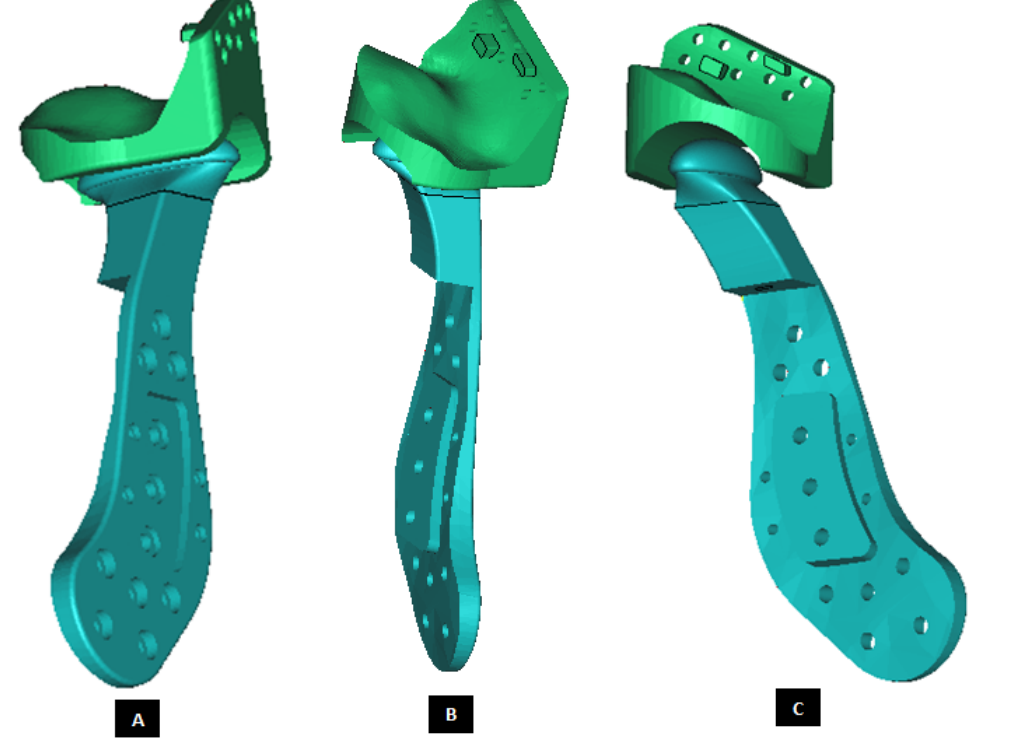
Figure 24. A patient-specific total TMJ prosthesis with medial notches in fossa and condylar compo- nents. ( A ) Shows anterior–lateral view of the ‘notched implants’ with screw holes. Fossa prosthesis has two medial notches to be fit into host bone ( B , C ). The articular surface of fossa implant has medio–lateral openings, and is designed to allow optimal anterior and medial translation along with rotation of the prosthetic condylar head along the medio–lateral